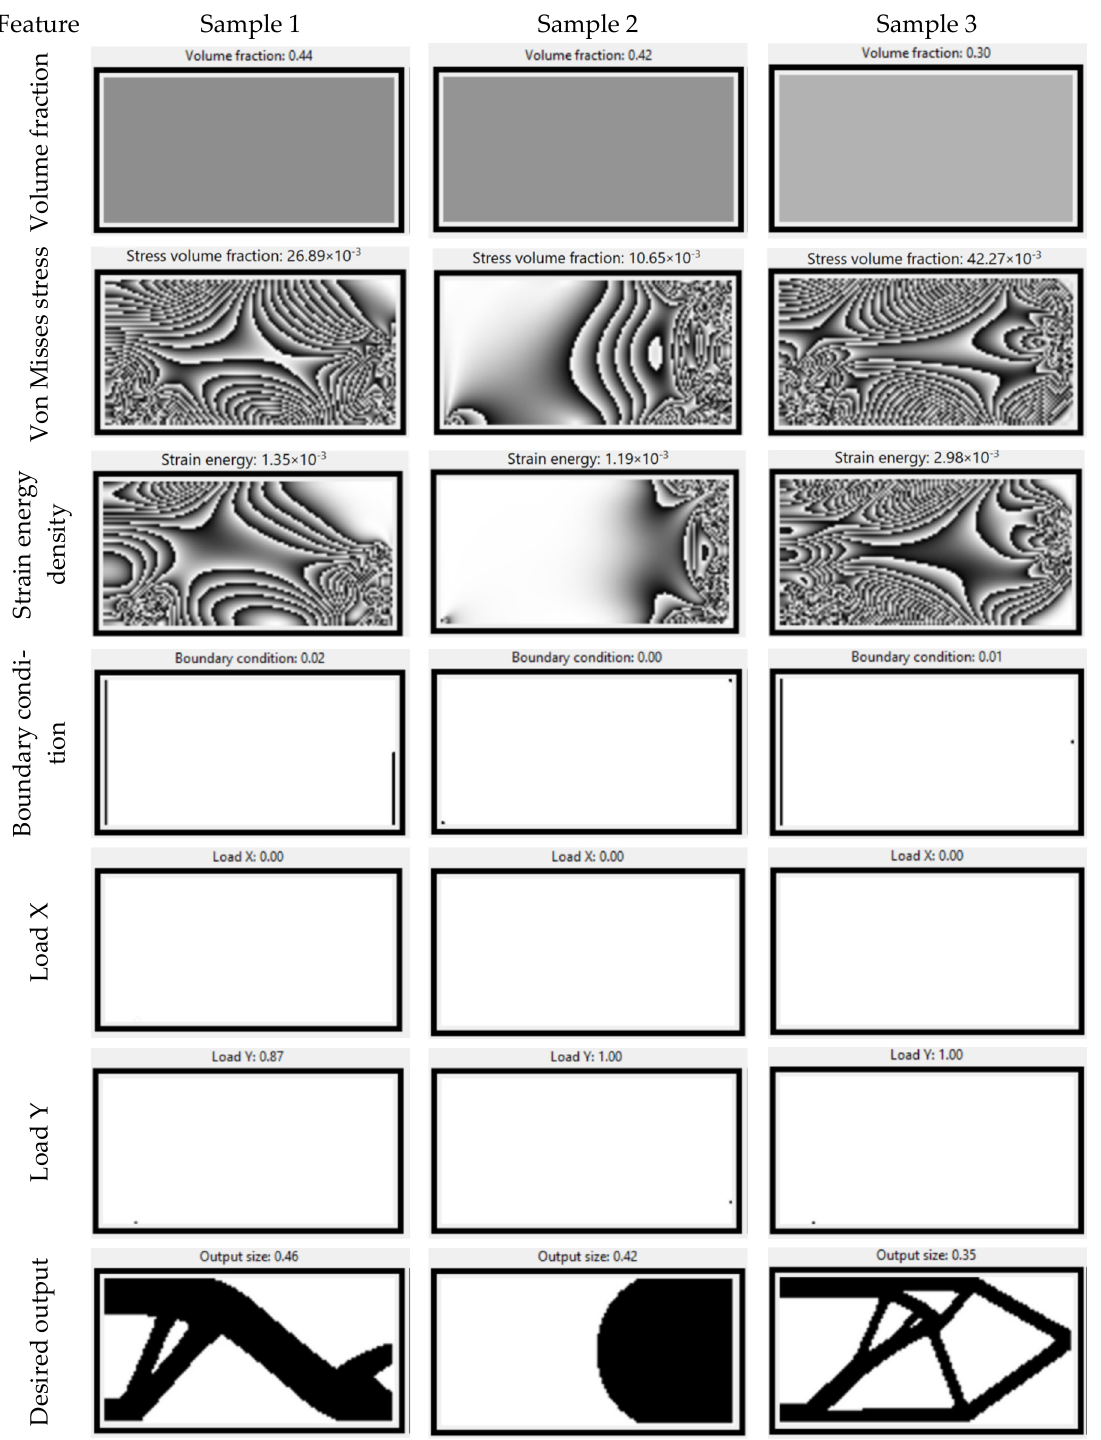
Figure 3. Visual representation of samples of dataset #2.